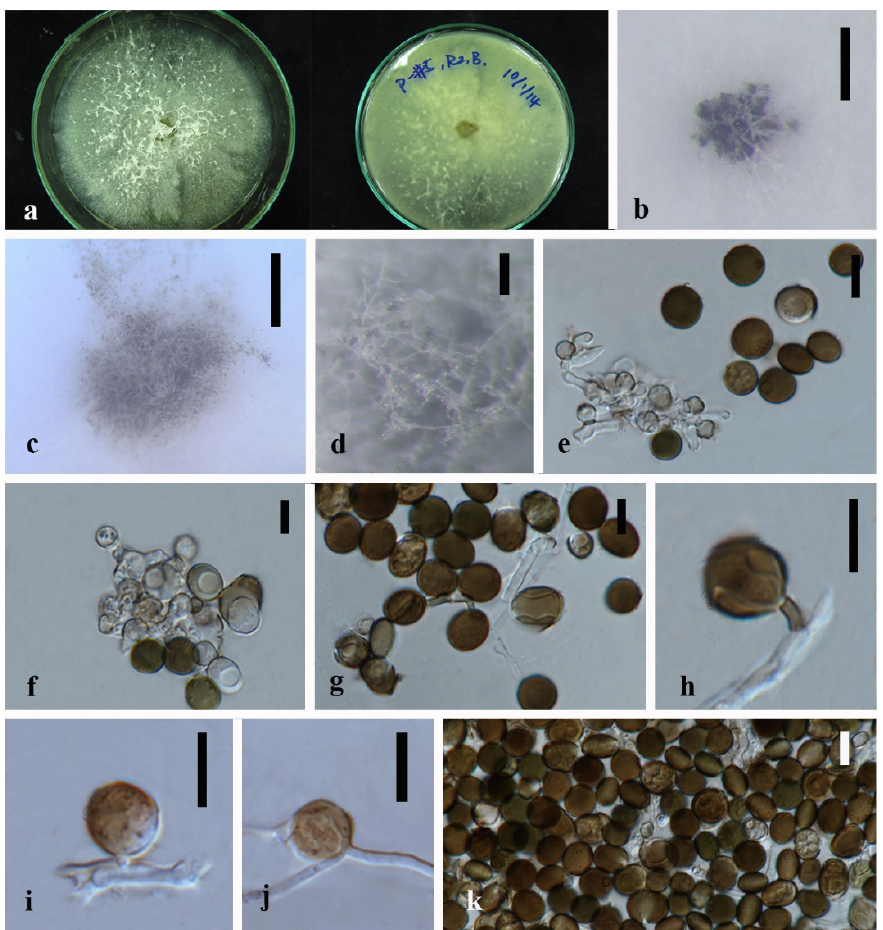
Figure 3. Apiospora dendrobii (MFLU 21-0153). ( a ) Colony on PDA (left-front view, right-reverse view). ( b – d ) Conidiomatal mass. ( e – g ) Conidiophores with conidia. ( h – j ) Chlamydospores. ( k ) Conidia. Notes: ( b – k ) on 4% OA. Scale bars: ( b ) = 100 µ m, ( e – k ) = 10 µ